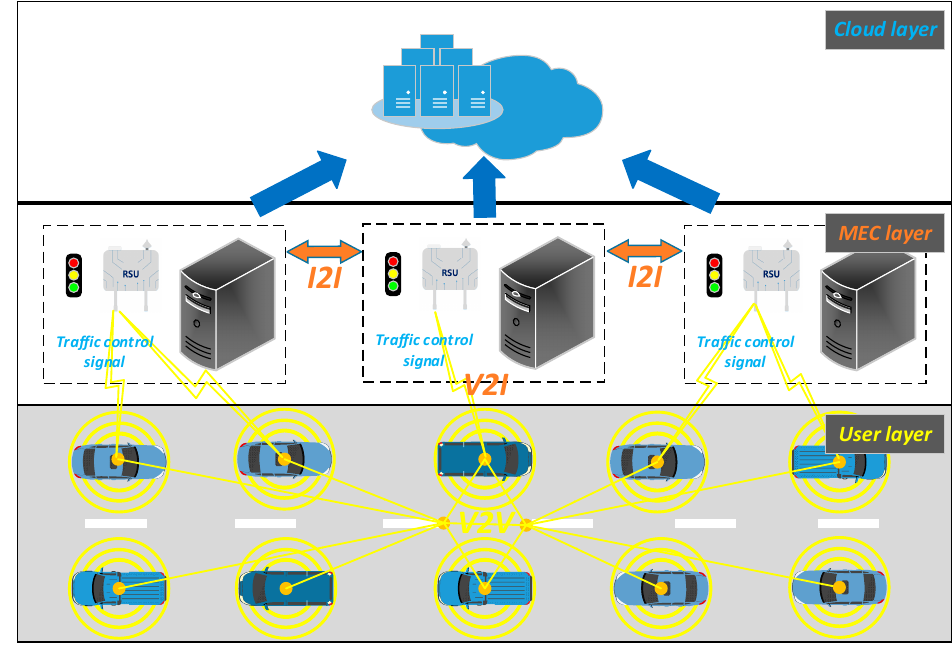
Figure 1. Edge swarm intelligence ATSC environment.